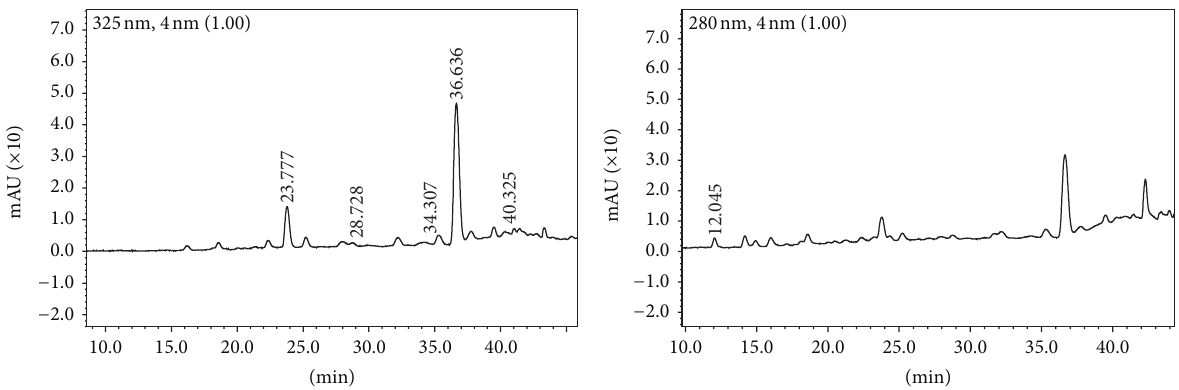
Figure 4: HPLC chromatogram of the crude methanolic stem extract of Plectranthus amboinicus . Antioxidants present and their corre- sponding retention times (min); gallic acid—12.04 (280nm); caffeic acid—23.77 (325 nm); p -coumaric acid—28.72 (325 nm); rutin—34.30 (325 nm); rosmarinic acid—36.63 (325 nm); and quercetin—40.32 (325nm).